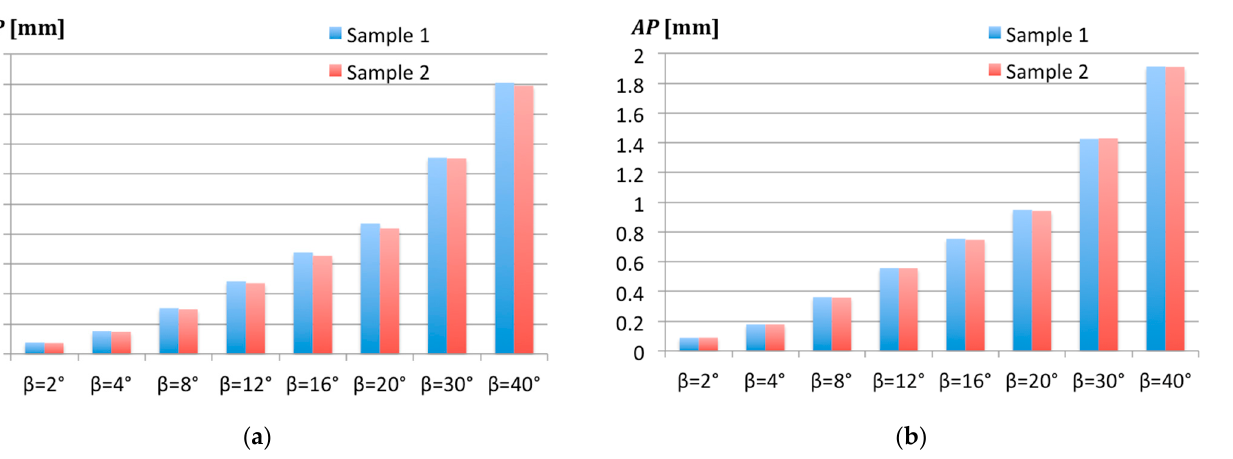
Figure 10. Measured surface impact on the positioning accuracy AP at different angles β for α = 0 ° : ( a ) For Probe 1 ( ∅ 2 mm); ( b ) For Probe 2 ( ∅ 5 mm).